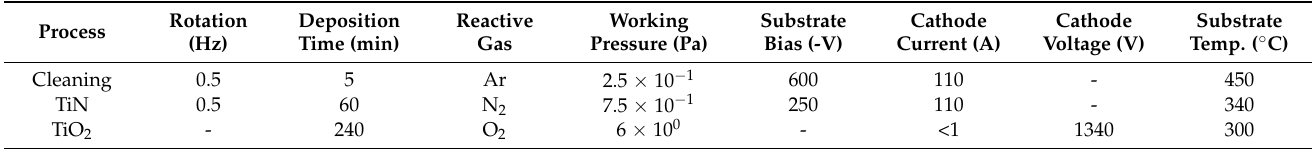
Table 1. Main parameters and consistent deposition of the TiN/TiO 2 multilayered film. Rotation Process